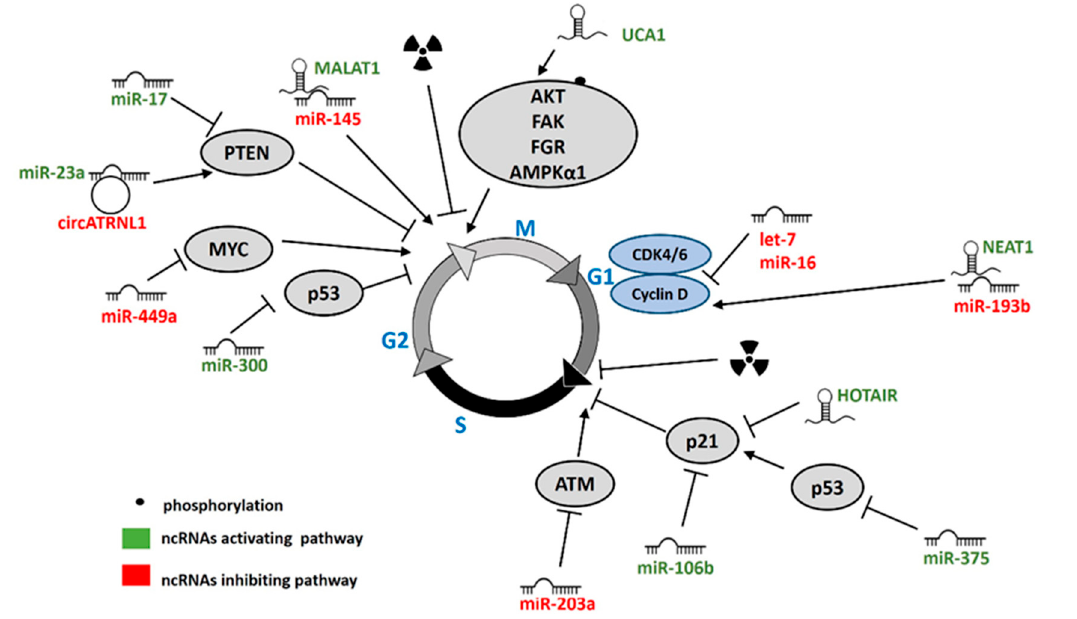
Figure 4. ncRNAs regulating IR-induced cell cycle. ncRNAs promoting (green) or inhibiting (red) cell cycle progression.